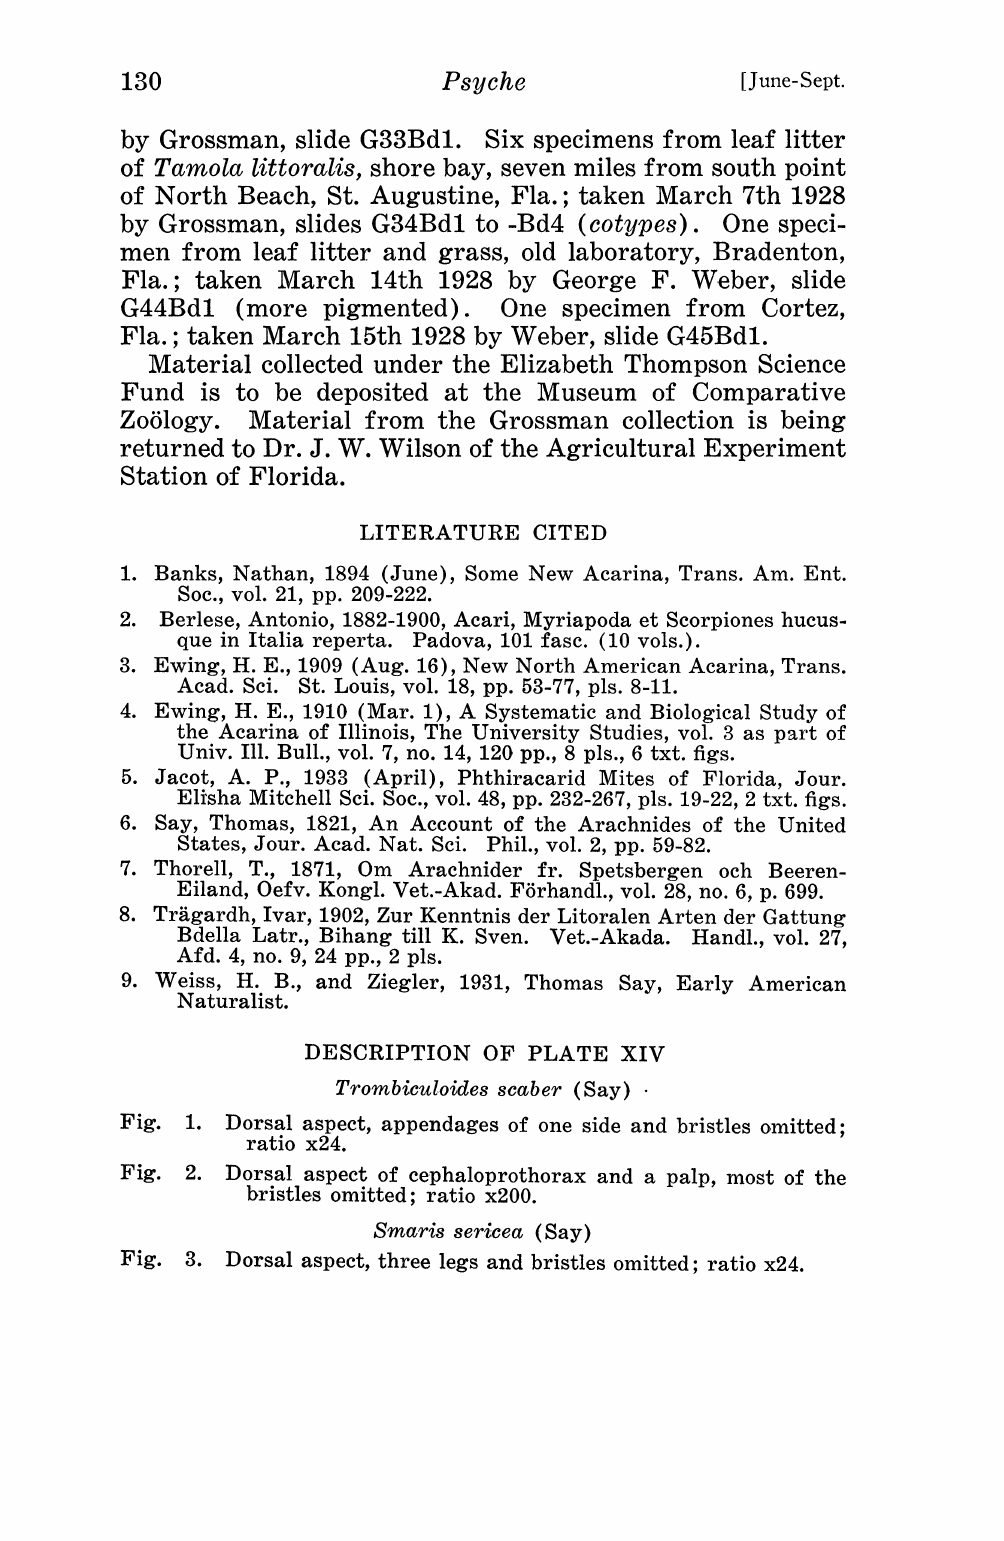
DESCRIPTION OF PLATE XIV Trombiculoides scaber (Say) 1. Dorsal aspect, appendages of one side and bristles omitted; ratio x24. 2. Dorsal aspect of cephaloprothorax and a palp, most of the bristles omitted; ratio x200. Smaris sericea (Say) Fig. 3. Dorsal aspect, three legs and bristles omitted; ratio